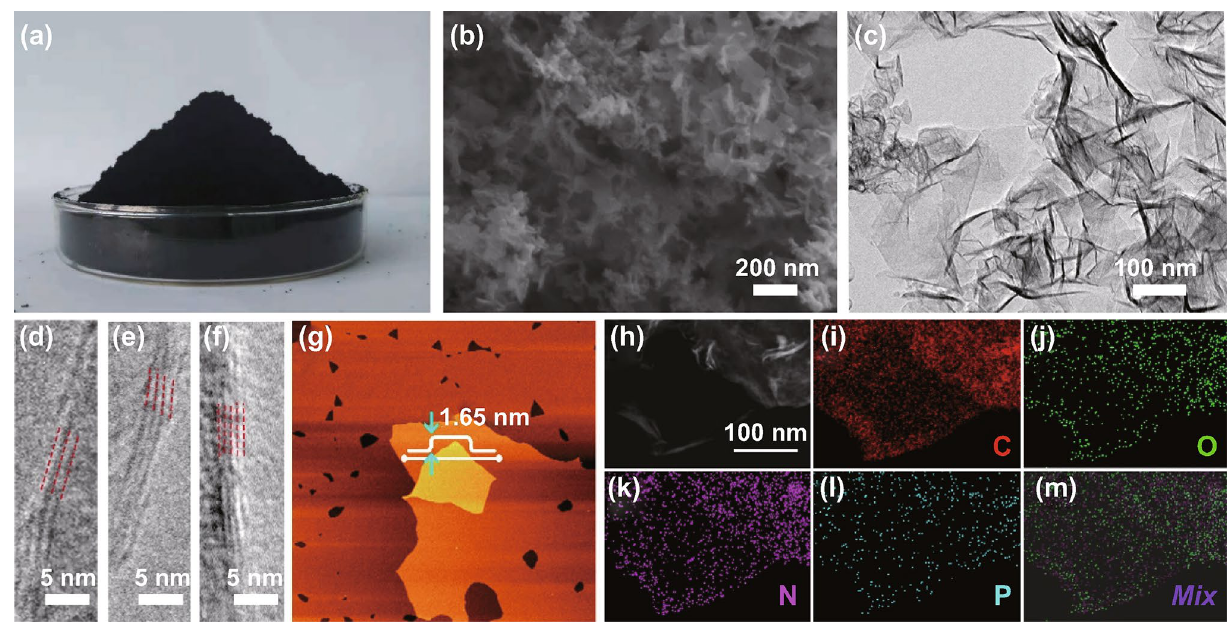
Fig. 2 a NPG powder on a culture dish. b SEM and c TEM images of NPG nanosheets. High-resolution TEM images of NPG nanosheets with d two, e three, and f five graphene layers. g AFM image and height profile of NPG nanosheets. h Corresponding mapping images and that of i carbon, j oxygen, k nitrogen, and l phosphorus elements along with their superimposition ( m